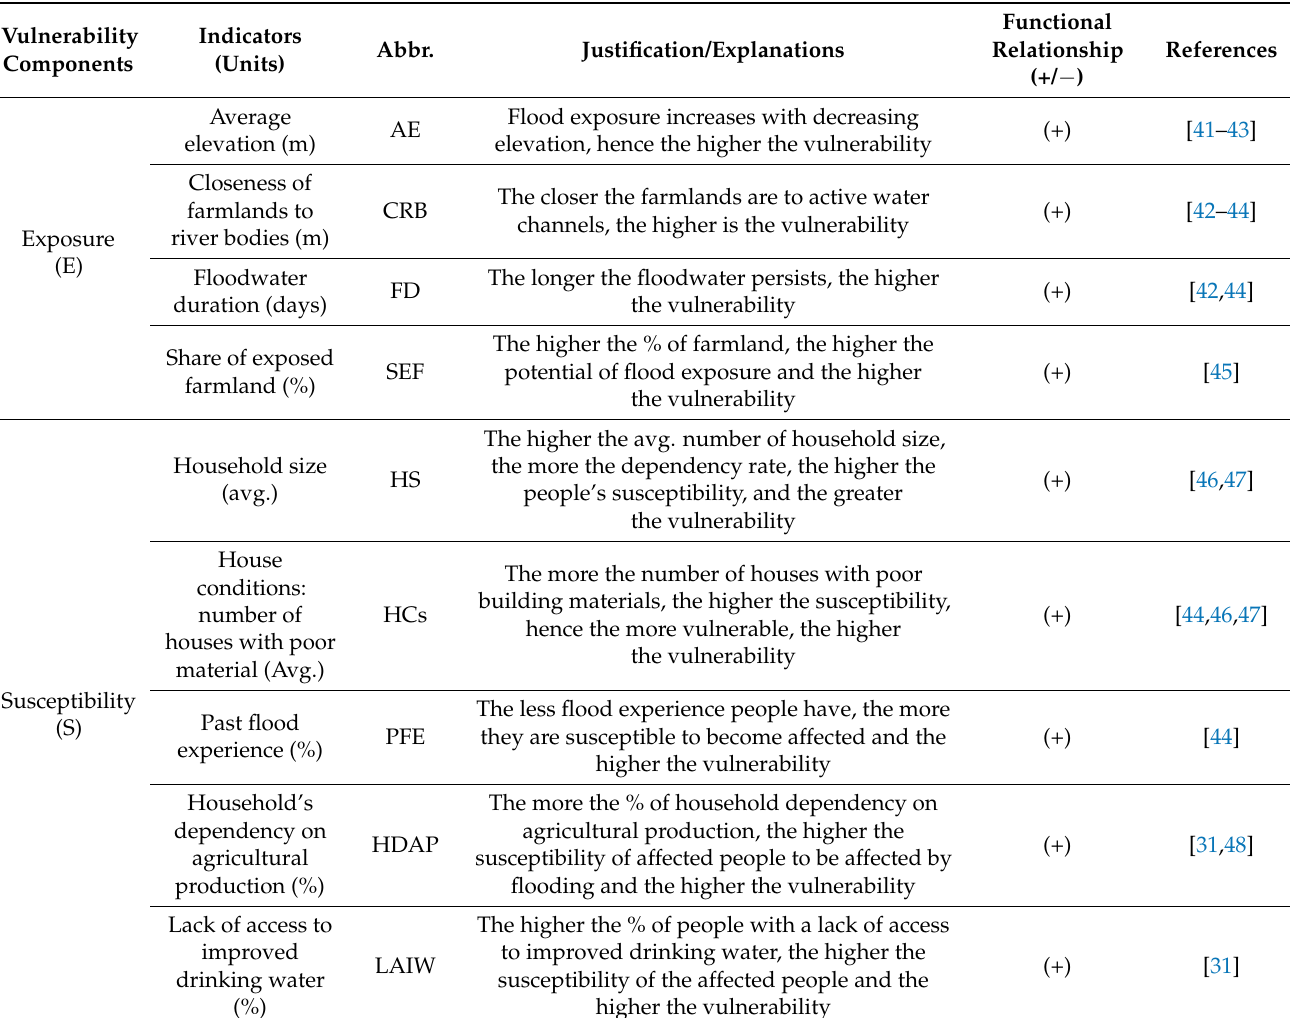
Table 2. Flood vulnerability indicators of flood-prone communities of Kogi State and their functional